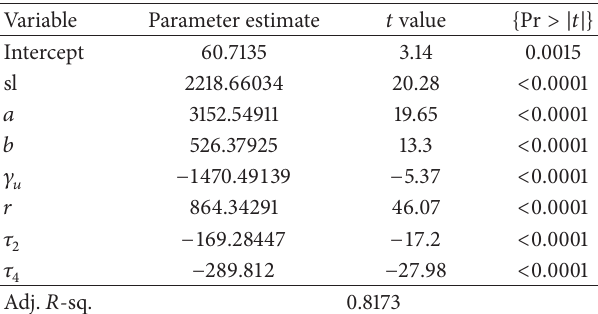
Table 4: Statistics of multiple linear regression for